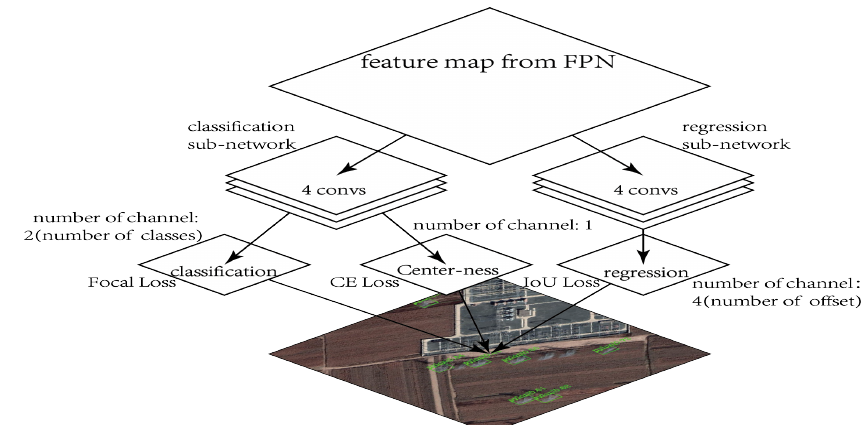
Figure 13. Structure of FCOS [32]. The structure of FCOS is similar with Retinanet [29]. The regression sub-network outputs four channels which present four offsets, while the classification sub-network outputs two channels presenting two categories. IoU loss [51] and focal loss [29] are used as regression and classification loss, respectively. Classification sub-network outputs another channel to restrain the inferior quality outer points, using center-ness